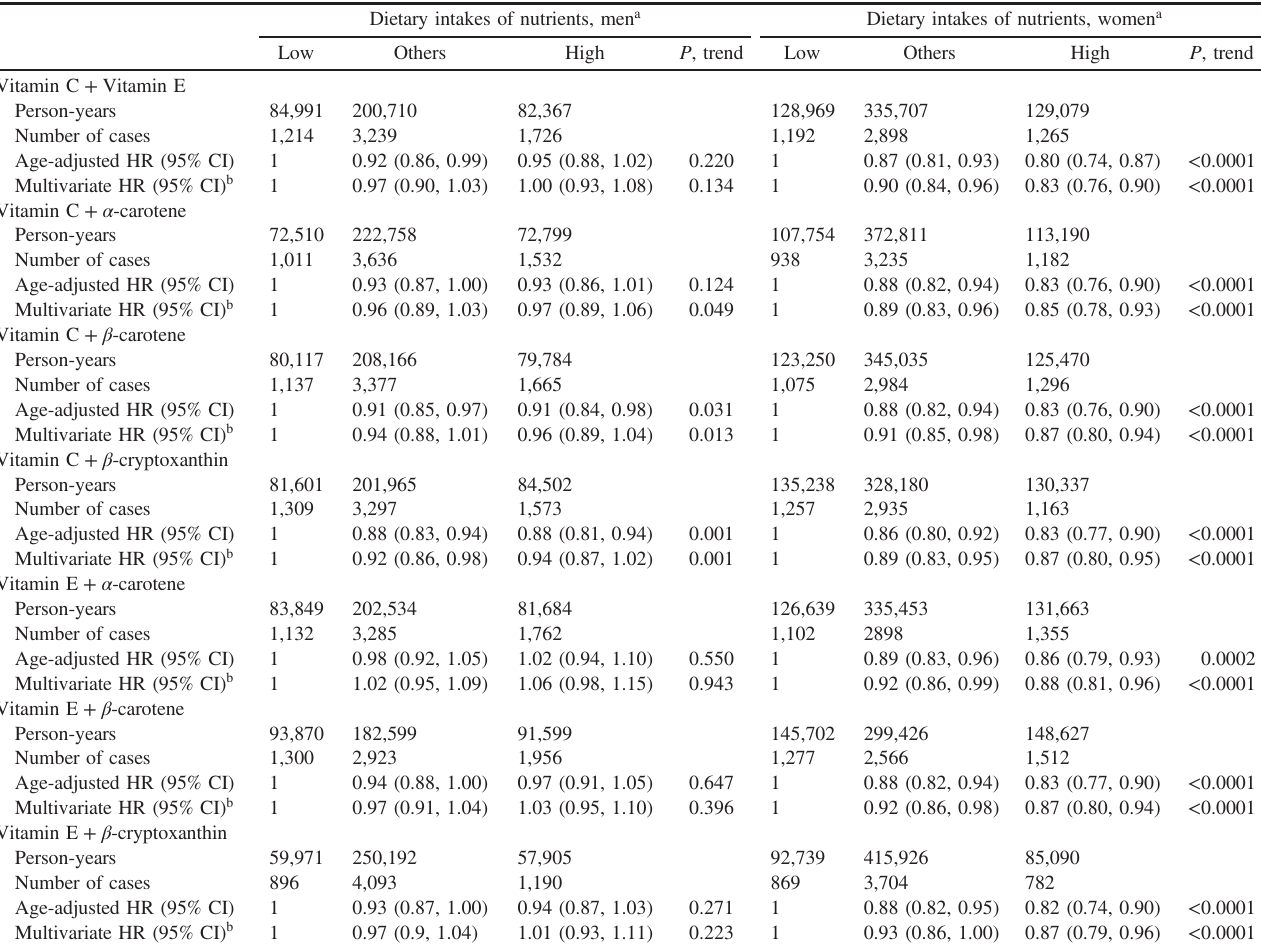
Table 3. Joint e ff ects of highly correlated antioxidant nutrients on all-causes mortality in men and women, JACC Study Dietary intakes of nutrients, men a Dietary intakes of nutrients, women